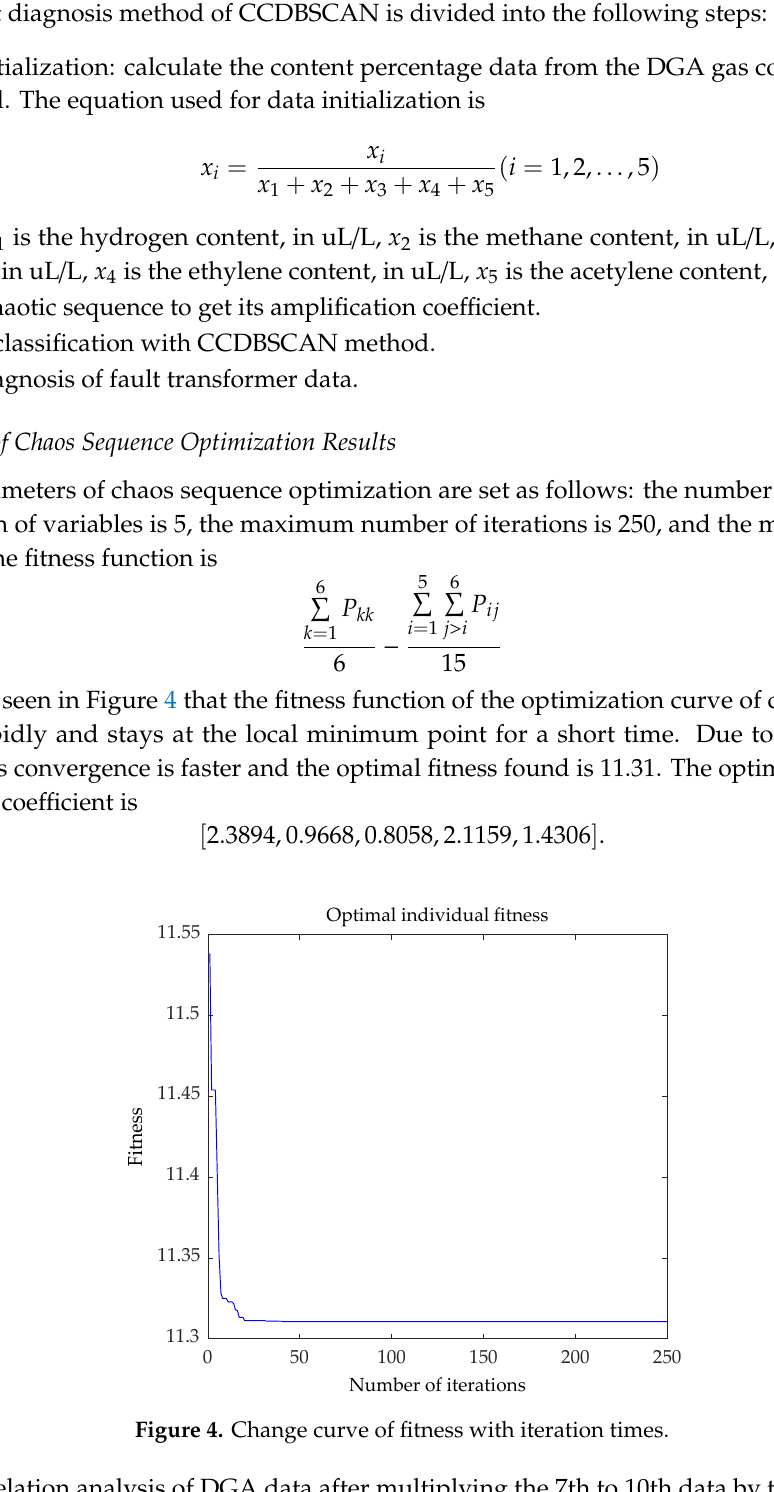
Figure 5. Line chart of gas content after multiplying coefficient. The correlation coefficient matrix of DGA data in Articles 7 to 10 is as follows: 1